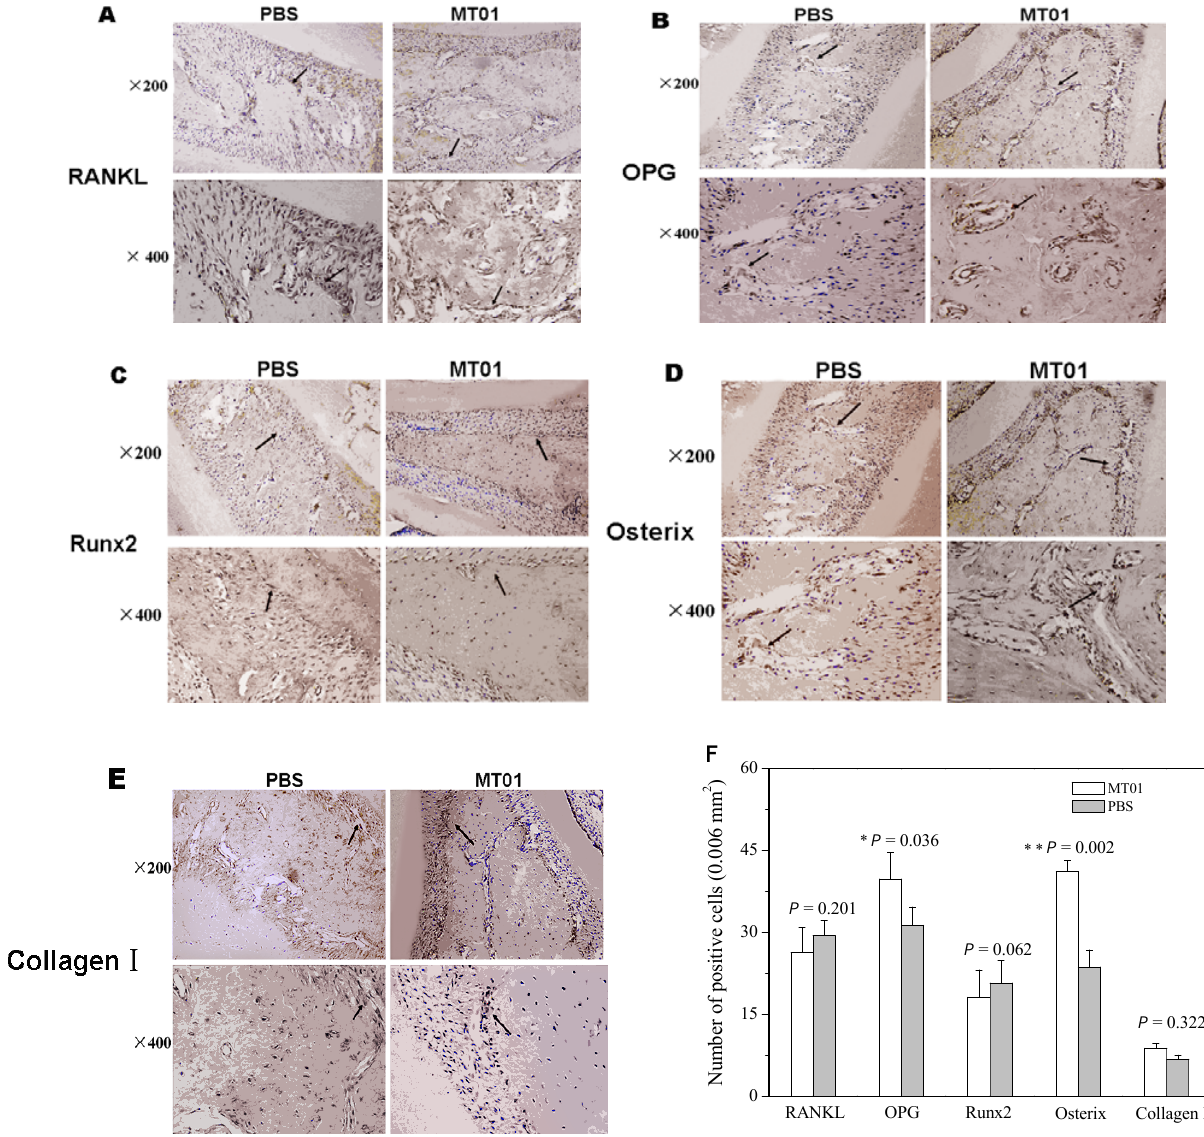
Figure 5. Effect of MT01 on the production of proteins of bone-associated factors. In the sections of the alveolar bone, RANKL ( A ), OPG ( B ), Runx2 ( C ), Osterix ( D ) and collagen I ( E ) producing cells were recognized by their specific antibodies, respectively. The positive cells were analyzed statistically and shown in F . Data were expressed